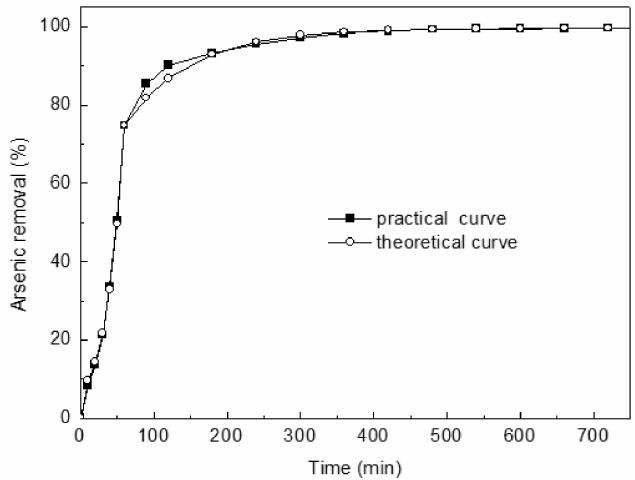
Figure 8. Comparison between experimental and theoretical kinetic